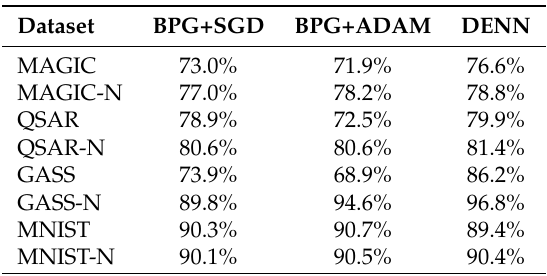
Table 5. Comparison BPG -